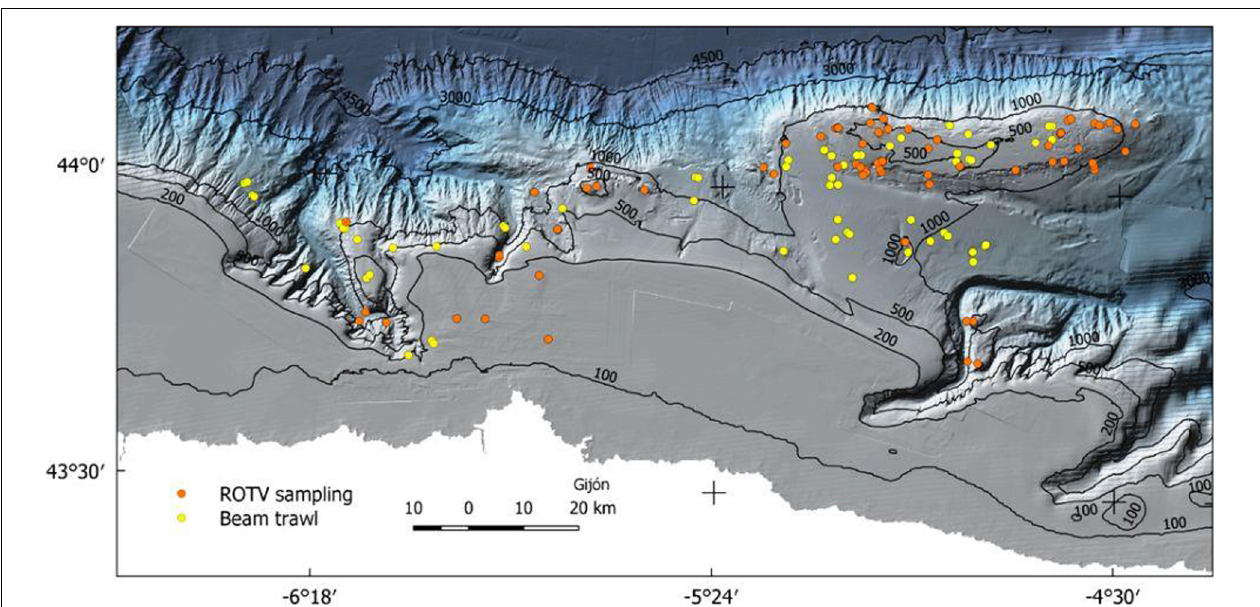
FIGURE 3 | Sampling effort in the study area for beam trawl and